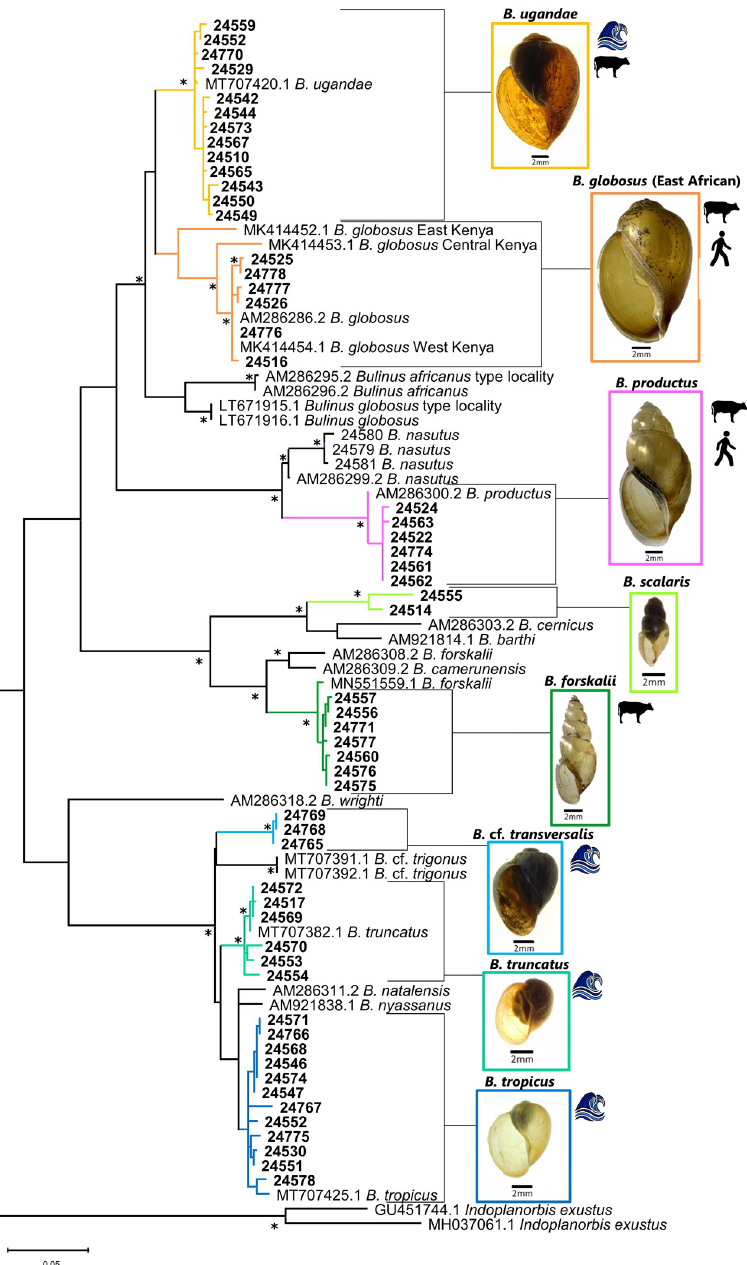
Fig 1. Phylogenetic relationships among Kenyan bulinids based on partial cox1 sequences. Phylogenetic relationships of bulinids from this study and from GenBank (with accession numbers) based on 621 bp of the cytochrome oxidase subunit 1 gene inferred from ML analysis under the GTR+G+I model. Bootstrap values over 95% are indicated by an asterisk. Bolded sequences were generated during this study and listed by MSB:Host: number. Additional information for specimens can be found in Table 1. Specimens recovered within the LVB by this study are color coded by species. B . africanus group species are in warm colors, B . forskalii group species in greens, and B . truncatus/tropicus group species in blues. Wave icons indicates species found within Lake Victoria. Cow icons indicate species with naturally occurring S . bovis infections. Human icons indicate species with naturally occurring S . haematobium